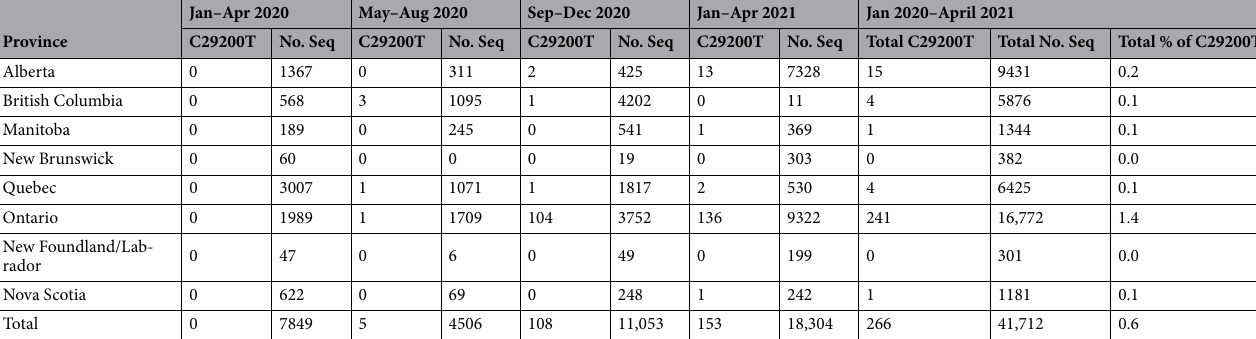
Table 1. Number of SARS-CoV-2 sequences with C29200T mutation and total number of sequences in